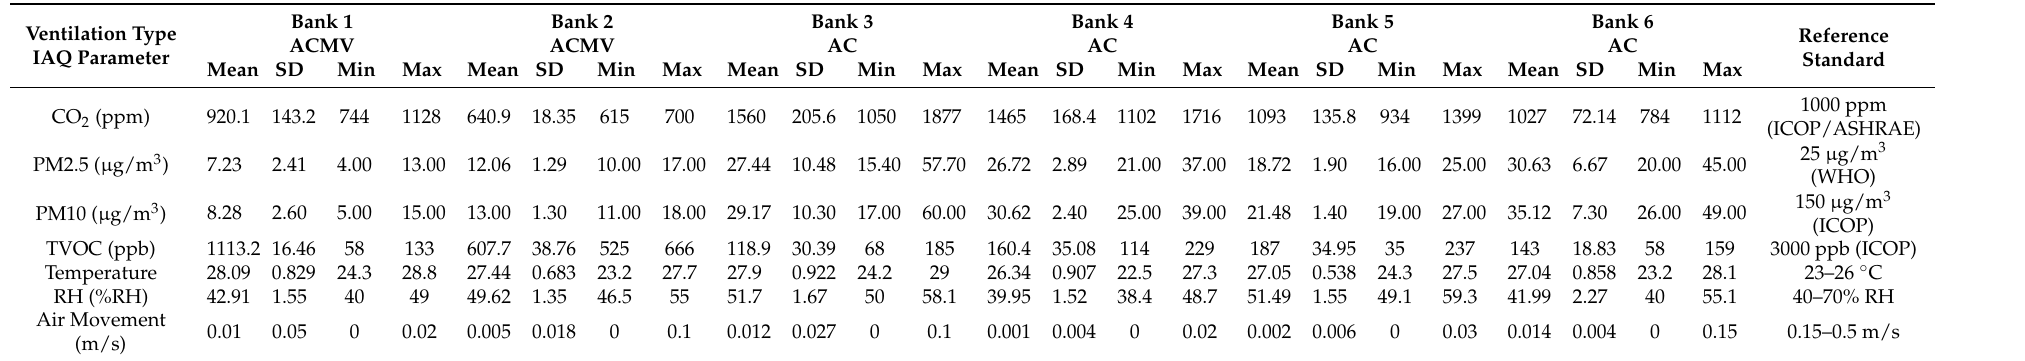
Table 2. Concentration of IAQ parameter at